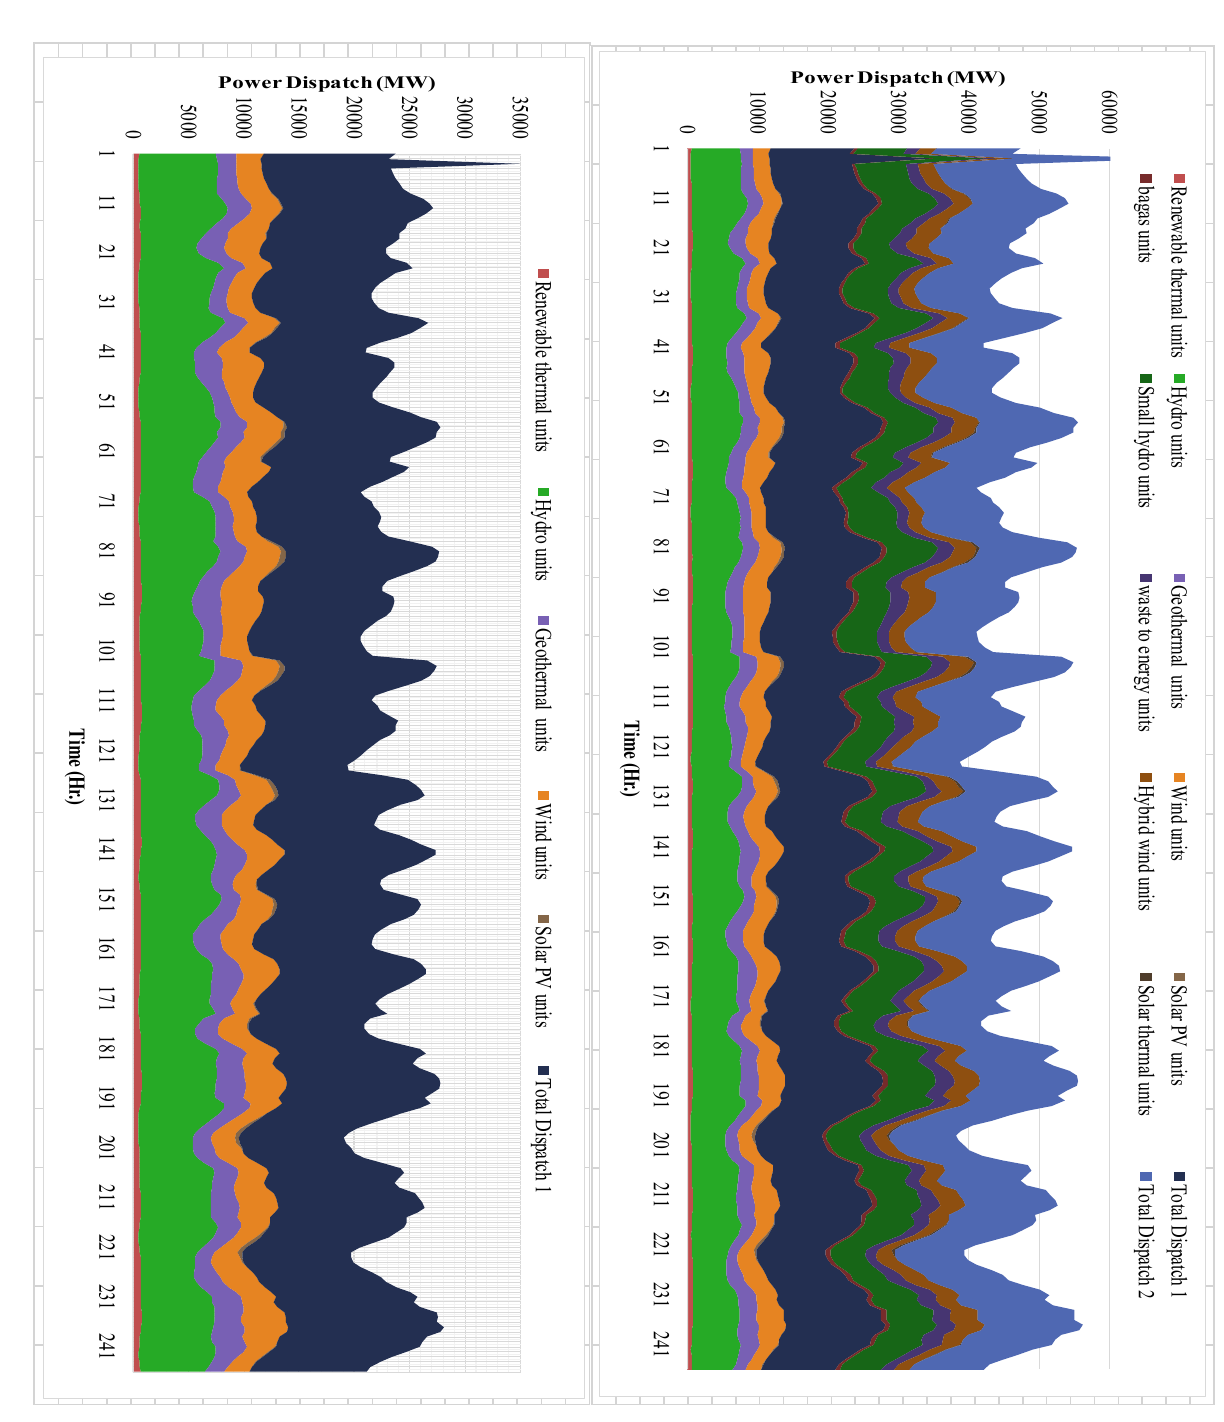
Figure 13. Weekly dispatch Ethiopian Renewable Energy